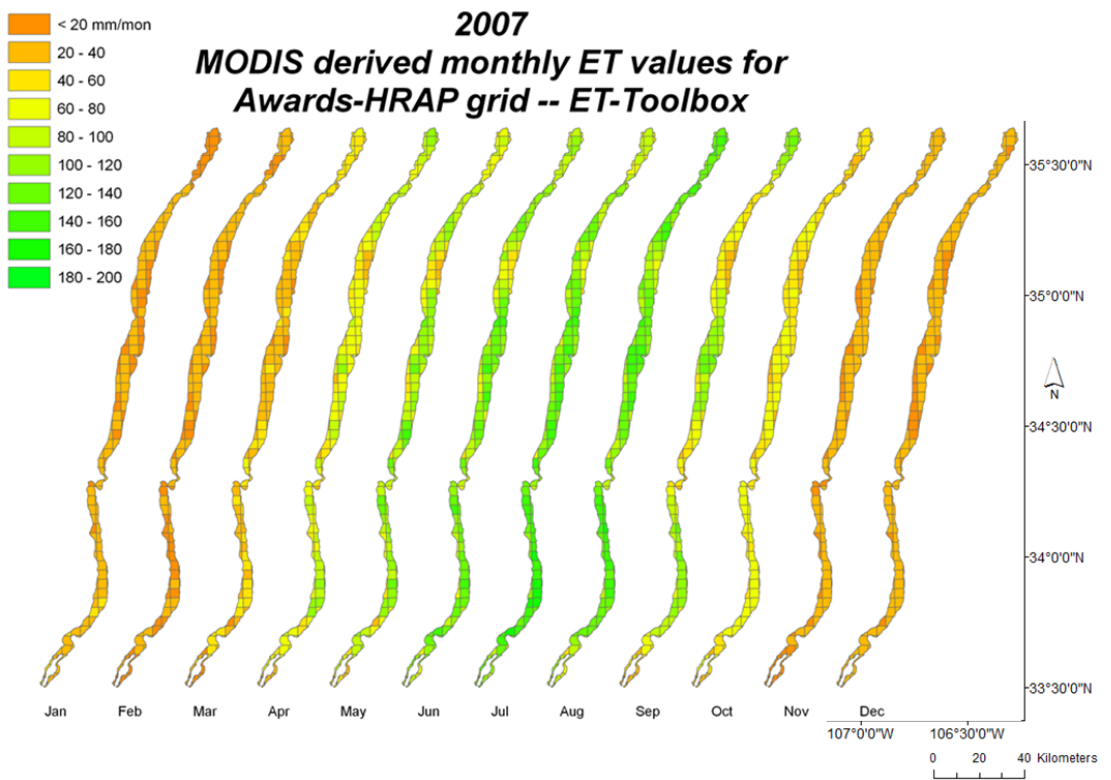
Figure 15. Monthly ET aggregated to 4 km sized grid cells of the ET-Toolbox grid along the Middle Rio Grande during 2007 (from Allen et al. [34]). Geographic coordinates refer to the December (Dec)